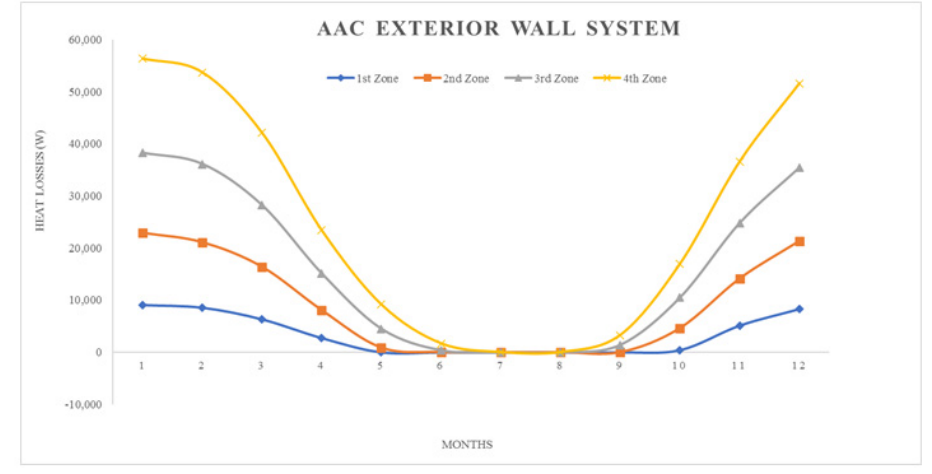
Figure 8. Heat losses for AAC exterior wall system.